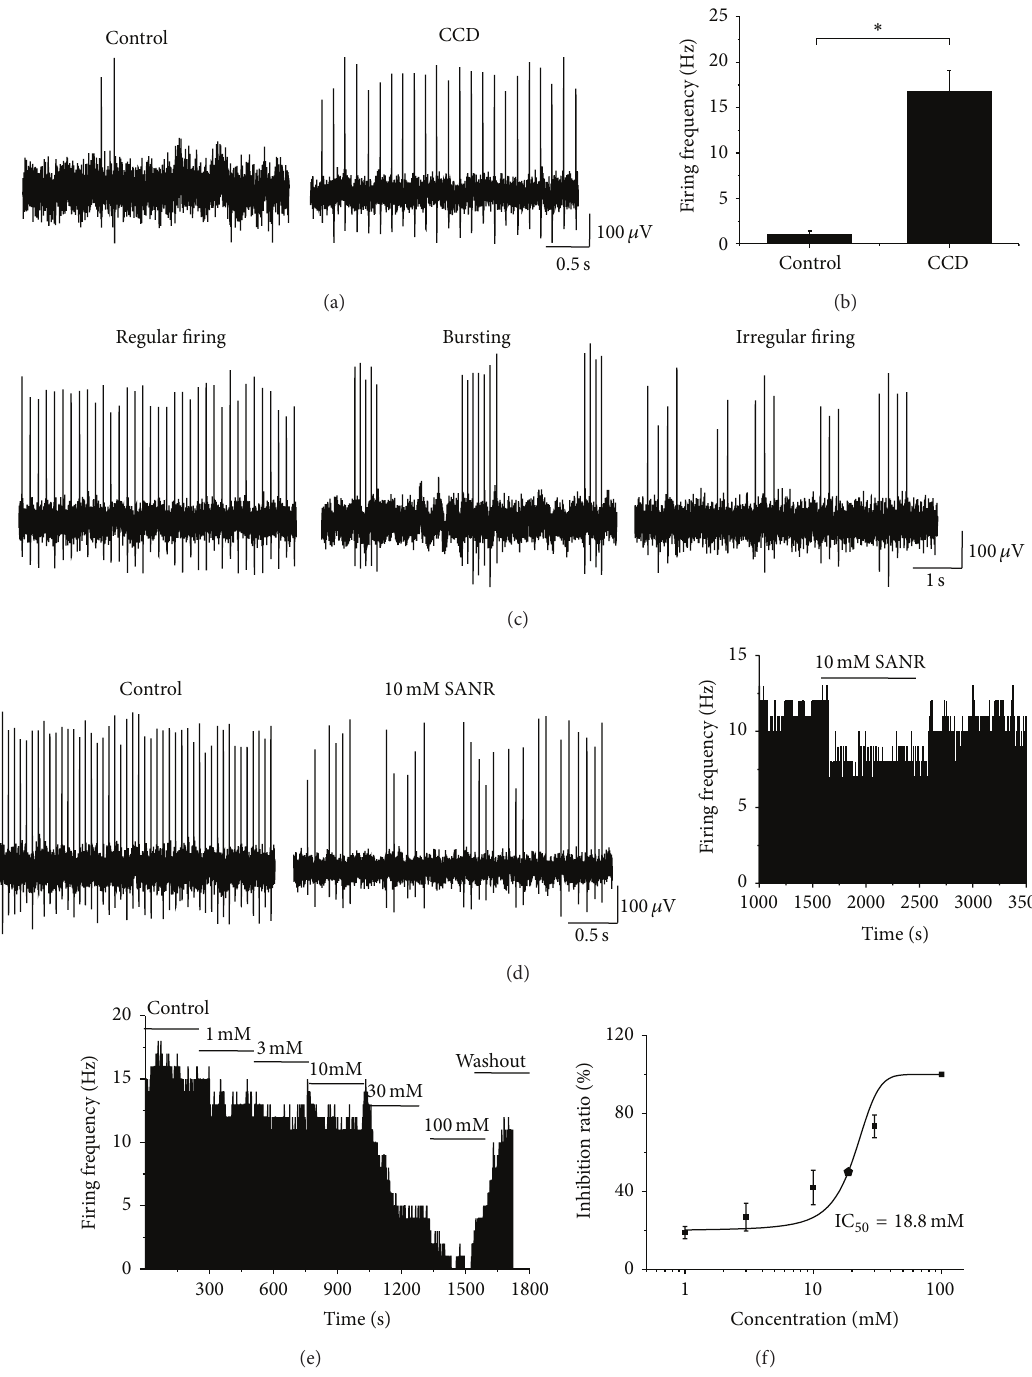
Figure 7: SANR produces dramatic inhibition on ectopic spontaneous discharges of the injured DRG neurons in CCD rats. (a) Following chronic compression of DRG, primary afferent A fibers of DRG neurons frequently exhibited ectopic spontaneous discharges (right panel); this rarely happens in sham control rats (left panel). (b) Quantitative analysis of the rate of spontaneous discharges in A-type DRG neurons derived from CCD and control rats. (c) According to the dynamic features of interspike interval series, three different firing patterns were observed, which are regular (left panel), bursting (middle panel), and irregular patterns (right panel). (d) Representative traces showing that bath application of SANR (10mM) (middle panel) produces marked depression of spontaneous discharge rate compared to vehicle in the same cell (left panel). Frequency histogram on the same cell was shown in the right panel. (e) Frequency histogram showing a dose- dependent inhibition of ectopic spontaneous discharges by SANR in a reversible manner. (f) Analysis of the curve based on the Hill plot yielded an IC 50 of 18.8mM for